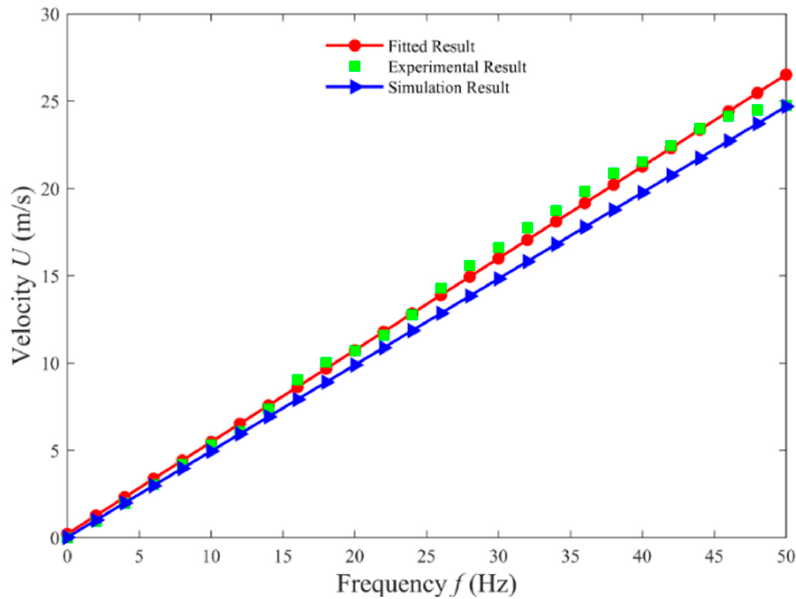
Figure 13. Variation of velocity with the converter frequency obtained experimentally and numeri- cally.